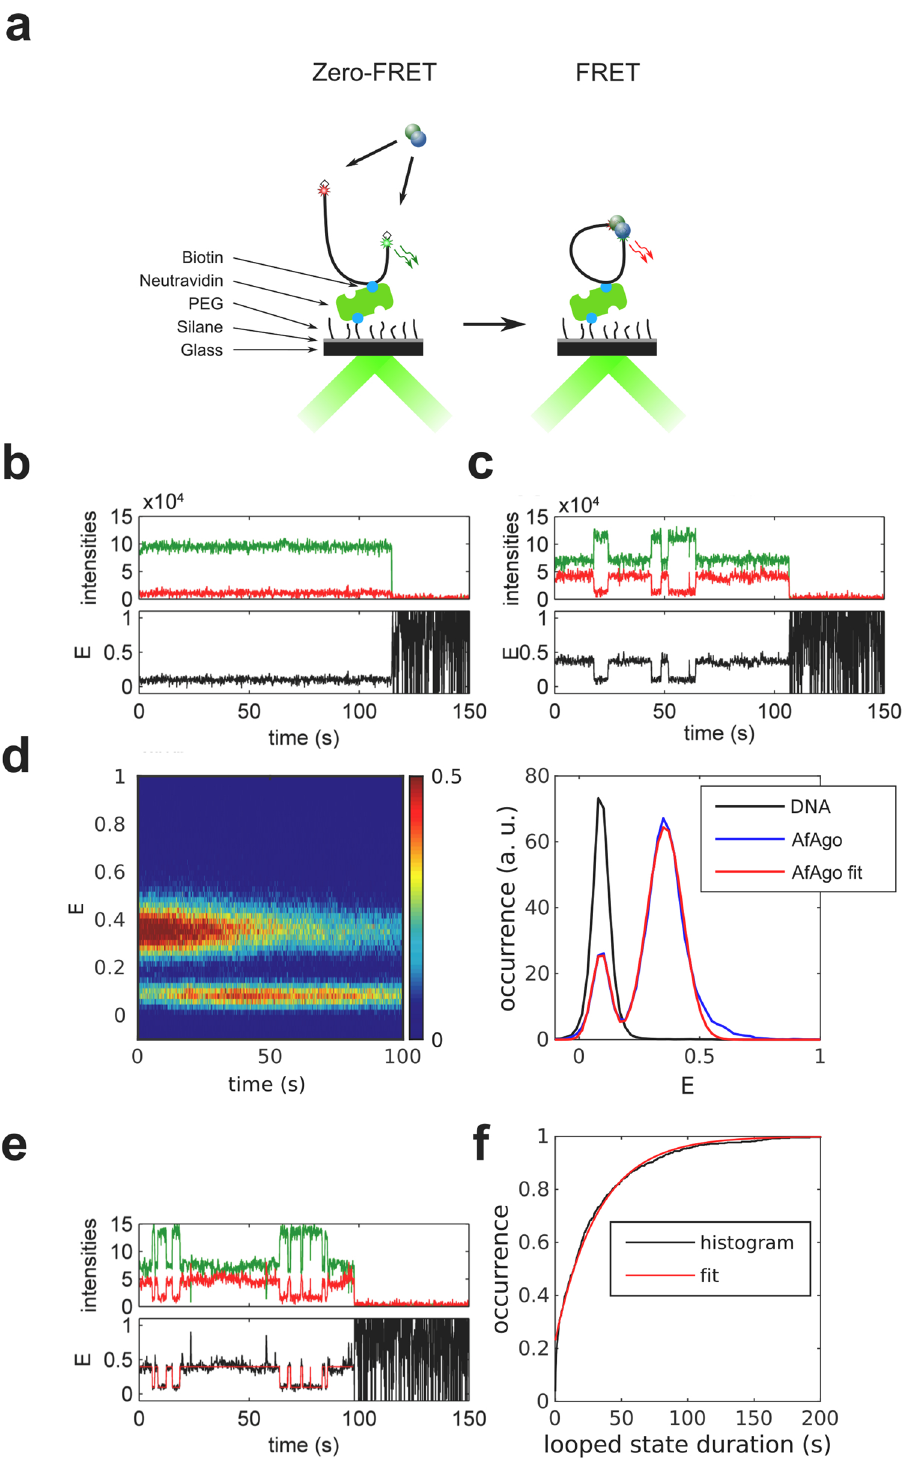
Figure 5. Dynamics of WT AfAgo-induced DNA loops. ( a ) A schematic overview of the single-molecule assay using TIRF microscopy. ( b , c ) Trajectories of donor (green) and acceptor (red) intensity and corresponding proximity ratio, E, of individual DNA fragments without ( b ) and with 20 nM WT AfAgo ( c ). ( d ) Left—an image of 287 pooled time traces of the proximity ratio, E, from the measurement with 20 nM of WT AfAgo. The image is normalized to the maximum image intensity. Right—a section of the image in the left integrated over the first 10 s shown with the two-Gaussian fit. The positions of the Gaussian maxima are 0.09 ± 0.01 and 0.36 ± 0.01. For comparison, a trace- and time-averaged section from the measurement of 227 traces on bare DNA is shown. ( e ) An example of trajectories of donor (green) and acceptor (red) intensity and corresponding proximity ratio, E, with HMM idealization of an individual DNA fragment with 20 nM WT AfAgo. ( f ) Cumulative histogram of the looped state durations from 287 E traces with a single-exponential fit with the exponential factor of 33 ± 1